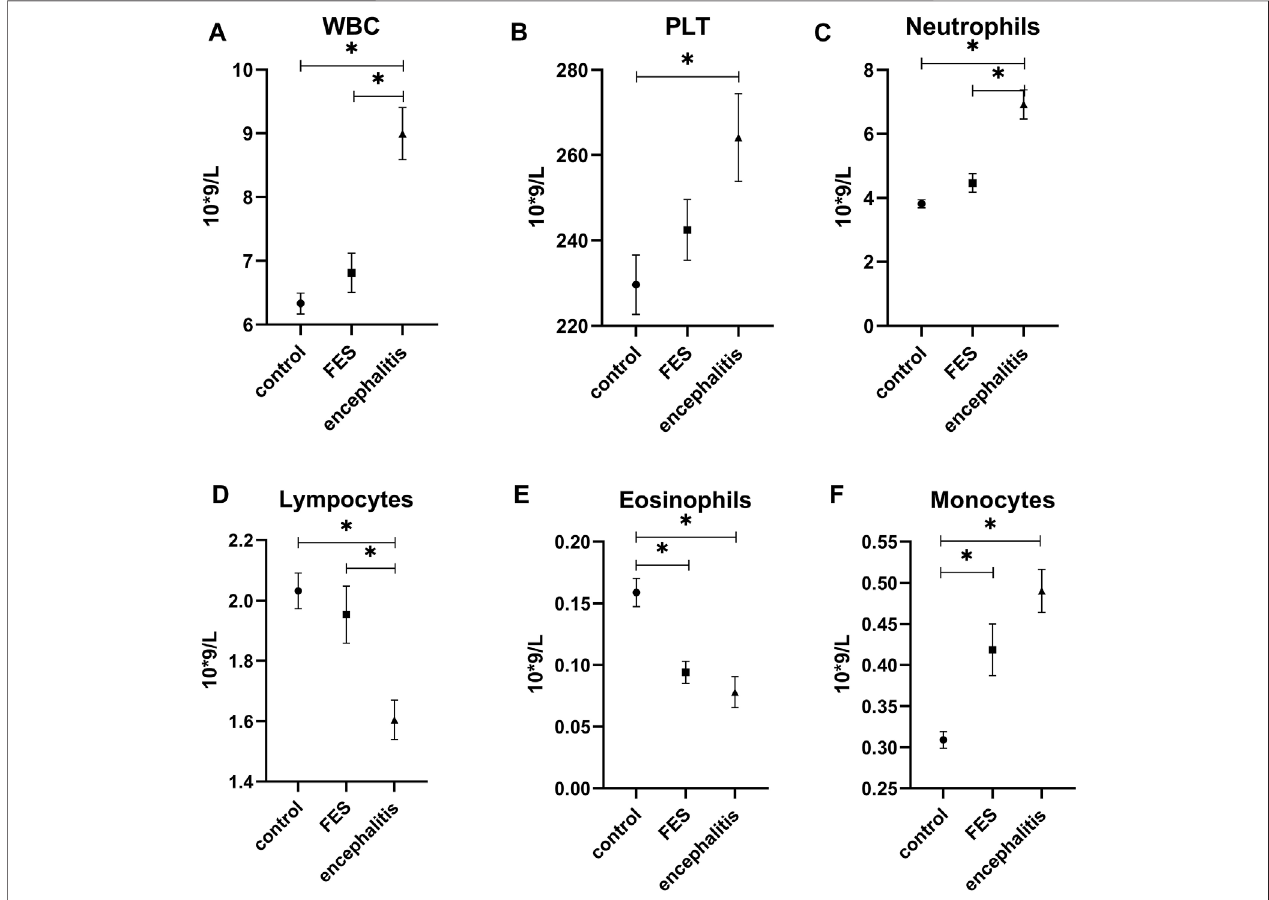
FIGURE1| Comparison ofWBC,PLT,neutrophils,lymphocytes,andeosinophilscountsinanti-NMDARencephalitis,FES,andhealthycontrol.FES, fi rst-episode schizophrenia; encephalitis, anti-NMDAR encephalitis; WBC, white blood cell; PLT, platelet. * p < 0.05. All the above hematological indicators except eosinophils were used Games-Howell tests, and the other two used the LSD test.